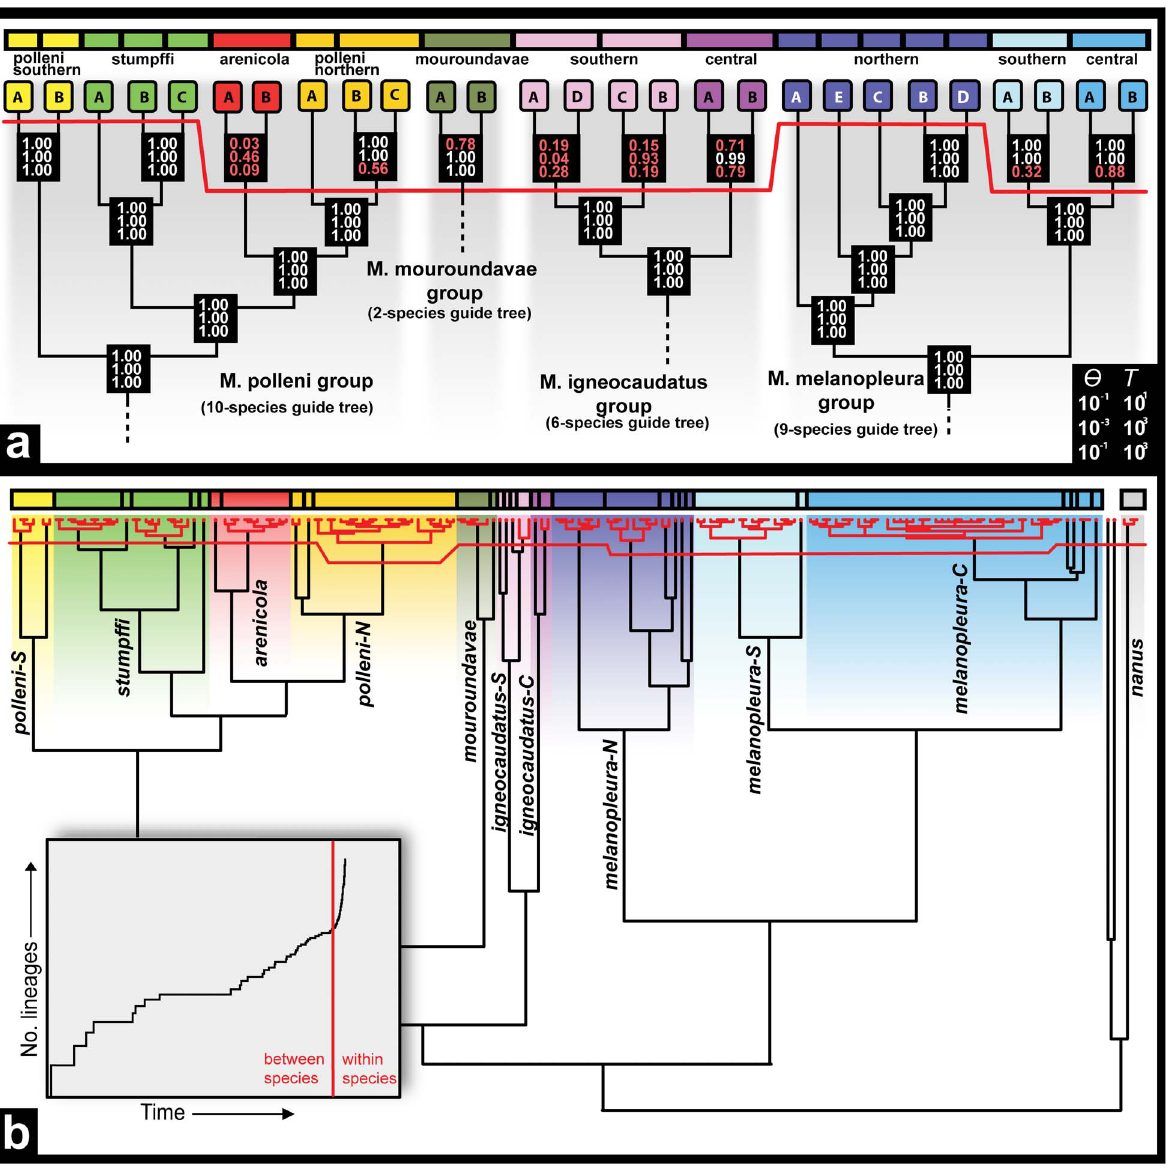
Figure 5. Results from the Bayesian Species Delimitation (BSD) and Generalized Mixed Yule-Coalescent (GMYC) approaches. Taxonomies resulting from both species delimitation approaches are summarized above each figure by a horizontal multicolored bar, each segment representing a different species. A: Guide trees used for each of the four BSD analyses (separately for the M. polleni , M. mouroundavae , M. igneocaudatus and M. melanopleura groups and assuming ten, two, six and nine species respectively (colored squares), cf. File S10 for details) are presented, with speciation probabilities provided for each node under each combination of priors for h and t o (top, prior means=0.1; middle, prior means=0.001; bottom, prior mean h =0.1, prior mean t o= 0.001). Only speciation events simultaneously supported by probabilities superior or equal to 0.99 for all three combinations of priors were considered to be relevant for species delimitation. The distinction between supported and non supported speciation events is represented by a horizontal red line above which each lineage represent a single and distinct species. B: The distinction between ‘‘inter-specific’’ versus ‘‘intra-specific’’ nodes estimated by the GMYC approach is represented by a horizontal red line, and all intra-specific relationships are colored in red on the mtDNA chronogram. The graphic in the grey box represent the lineages-through-time plot based on the ultrametric tree obtained from all mitochondrial haplotypes. The sharp increase in branching rate, corresponding to the transition from interspecies to intraspecies branching events, is indicated by a red line.